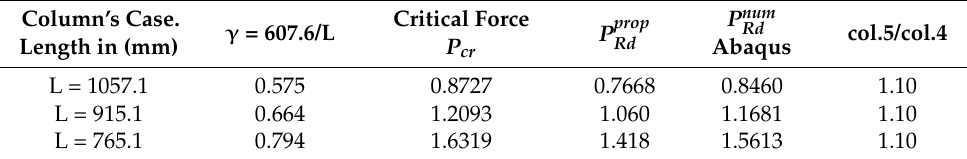
Table 8. Compressive resistance in [kN] for the case α = 2. Column’s